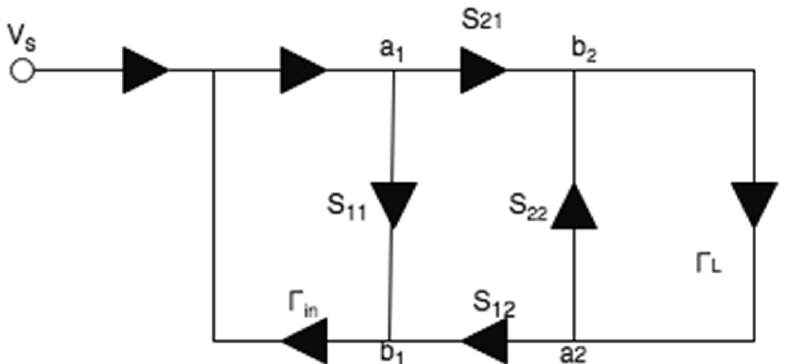
Figure 3. Two-port network used to simulate wireless communication with SDR and SAW device. S -parameters belongs to antennas, Γ in is the reflection coefficient measured on the LimeSDR-mini side, Γ L is the reflection coefficient from the SAW device